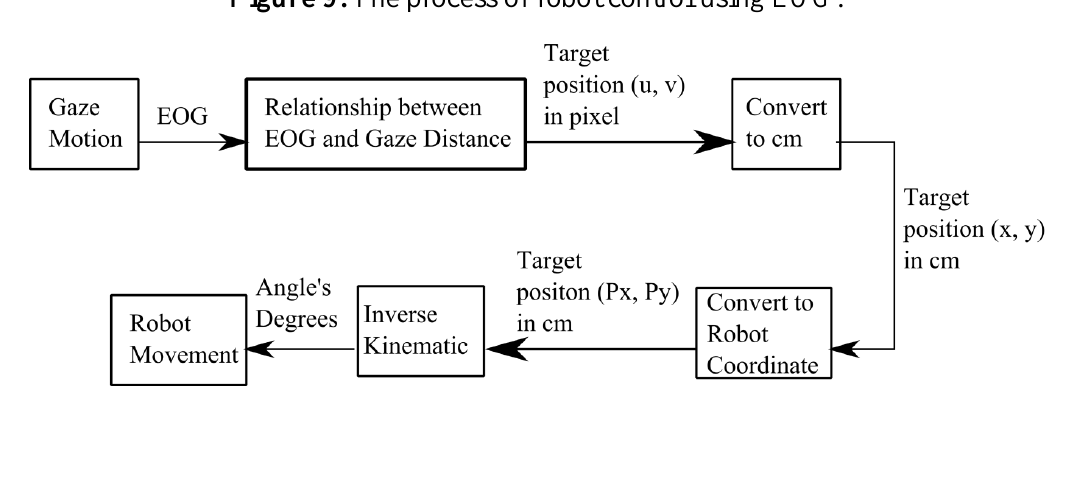
Figure 9. The process of robot control using